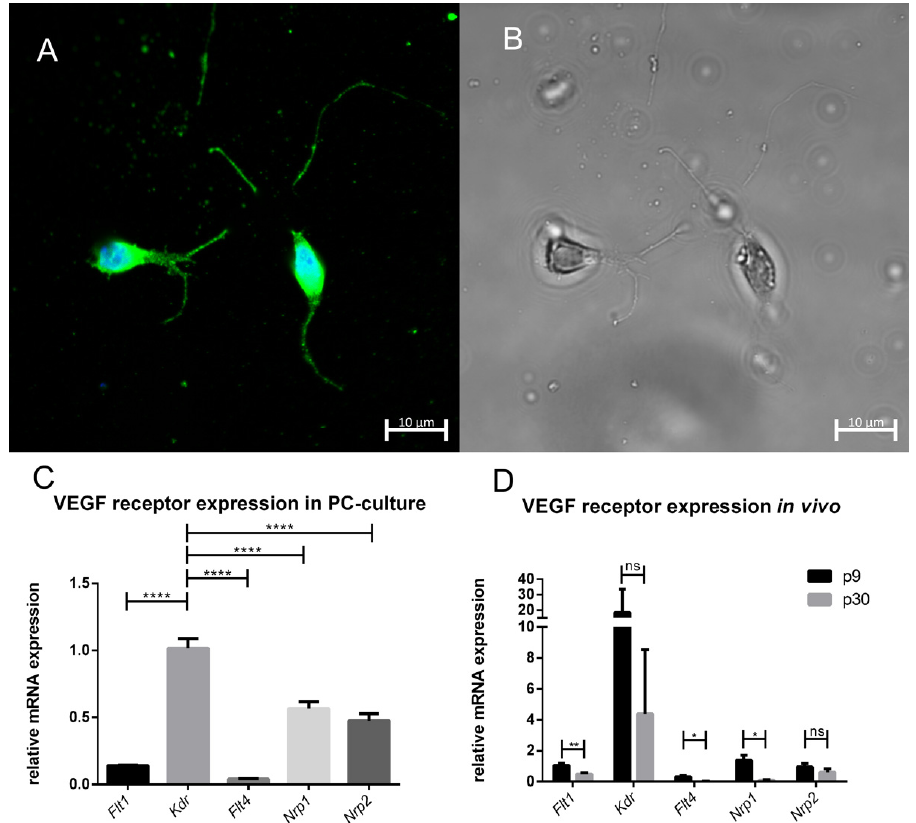
Figure 2. PC culture and VEGF receptor expression: ( A ) PCs were visualised via immunostaining with calbindin antibodies (green) and nuclear staining with Hoechst and in ( B ) with the help of phase-contrast optics. Scale bar: 10 µm ( C ) Quantitative analysis of VEGF receptor and co-receptor mRNA expression in an enriched PC culture. ( D ) The in vivo-grown PCs were dissected with the help of LMD. The housekeeping gene was Gapdh and the values were normalized against Flt1 . ( C ): n = 4, N = 4, ( D ): 1,000,000 µ m 2 of enriched PCs from 20 different rat cerebella were collected. The analysis was performed with the help of RT-qPCR and the 2 − ∆∆ ct method. Significant differences are indicated by * p < 0.05, ** p < 0.01, **** p < 0.0001; ns = not significant.